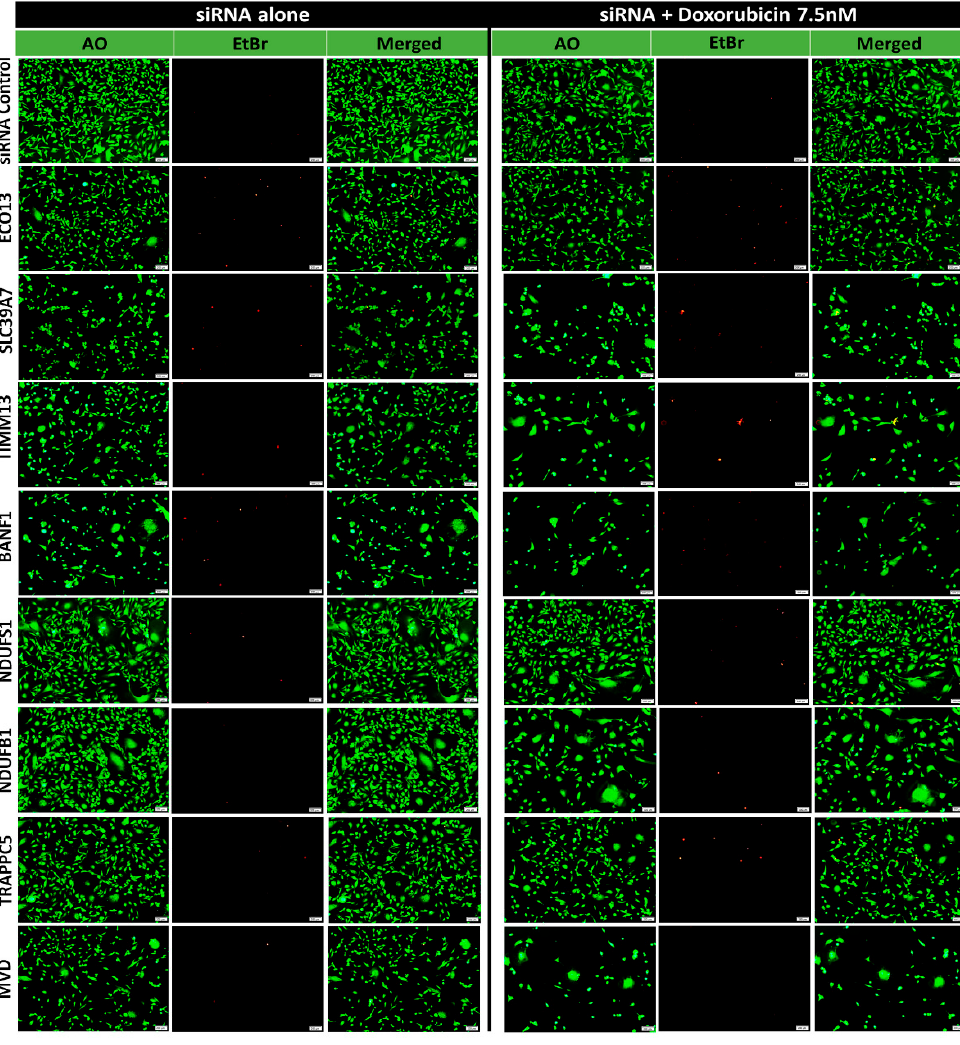
Figure 4. Viability fluorescent microscopy of MDA-MB-231 cells in response to siRNA-mediated gene silencing. MDA-MB-231 cells were transfected with the indicated siRNAs as single agent or in combination with doxorubicin (7.5 nM) and were visualized under fluorescent microscope for AO/EtBr staining on day 7. Representative images are shown.